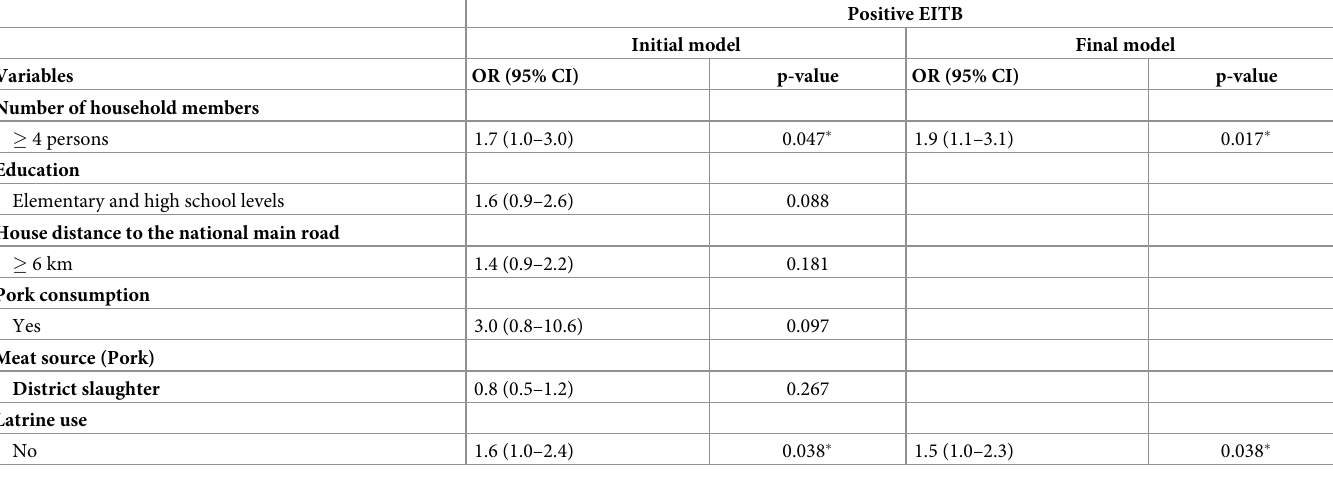
Table 5. Multivariable analysis on risk factors for exposure to T . solium infections (positive EITB).